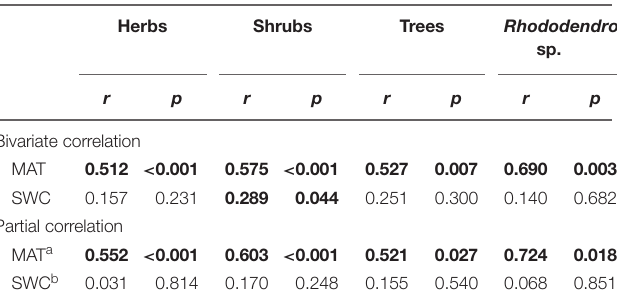
TABLE 3 | Pearson correlations ( r ) of MAT and SWC with (cid:2) of different plant functional types (PFTs; herbs, shrubs, and trees) as well as Rhododendron sp. growing on Mount Gongga.